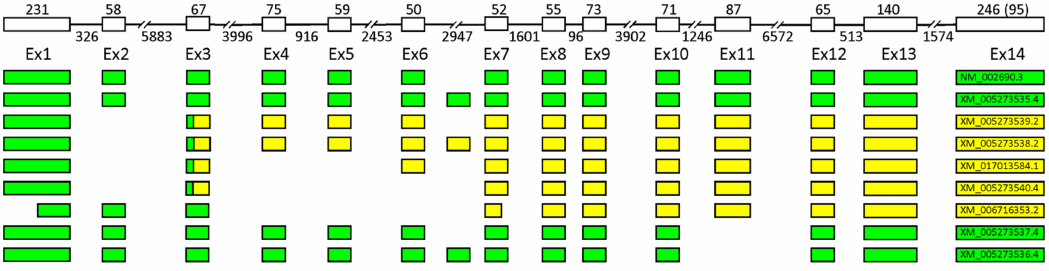
Figure 3. The schematic intron–exon organization of the human POLB gene and its common alternative splicing products. Untranslated regions are yellow, coding sequences are